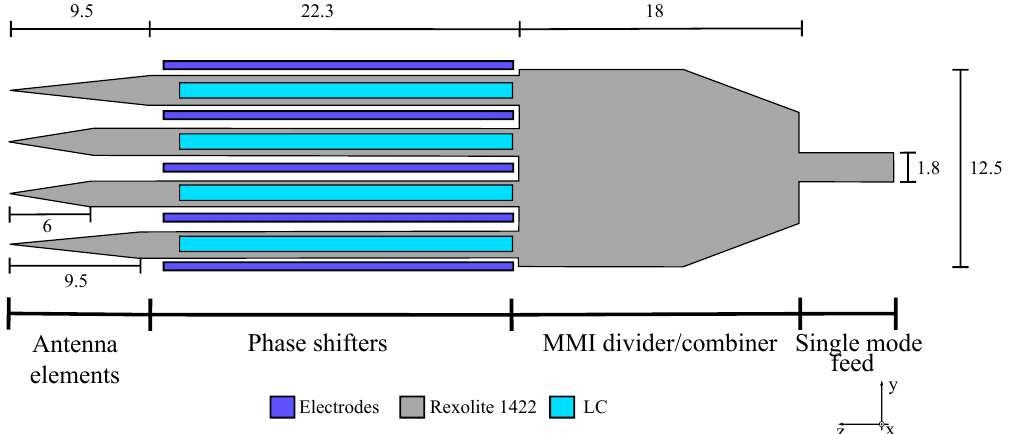
Figure 34. Layout of the fully dielectric 1